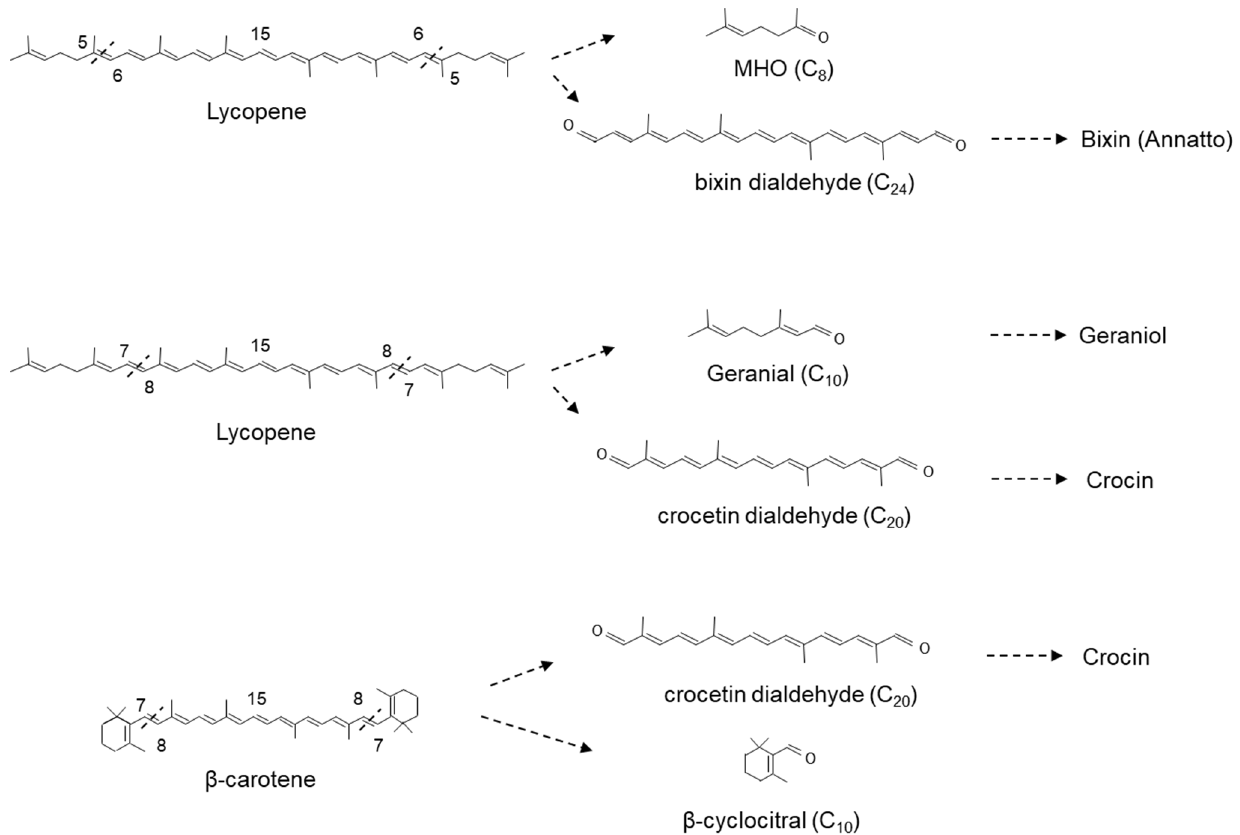
Figure 5. Scheme for the 5,6(5 ′ ,6 ′ ,) and 7,8(7 ′ ,8 ′ ,) reactions catalysed by the recombinant carotenoid cleavage deoxygenases (MHO; 6-methyl-5-hepten-2-one) carried out by CCD1 in the cytosol.